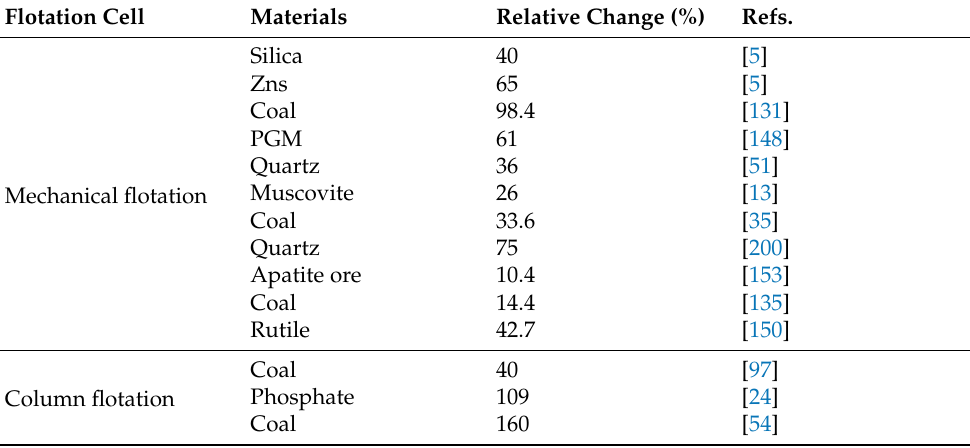
Table 5. Summary of observed changes in the flotation rate constant for mechanical and column flotation